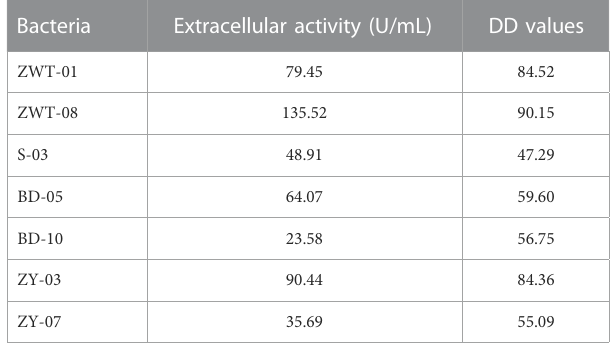
TABLE 1 Extracellular CDA activity and DD values of different strains in re-